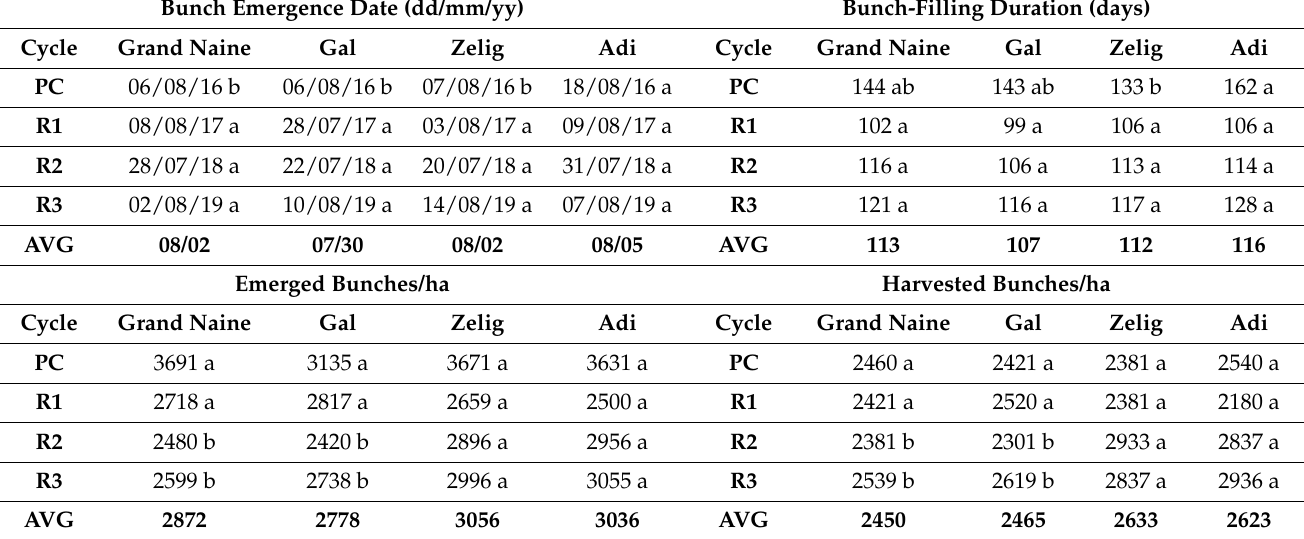
Table 2. Reproductive parameters for the various cultivars in each crop cycle and average of all cycles ( n = 150 plants/cultivar for bunch emergence date and bunch-filling duration in the various cycles). AVG is the mean of R1–R3 (bunch emergence date and bunch-filling parameters) and PC–R3 (emerged bunches per hectare and harvested bunches per hectare) cycles. Values in a row followed by the same letter are not significantly different ( p >